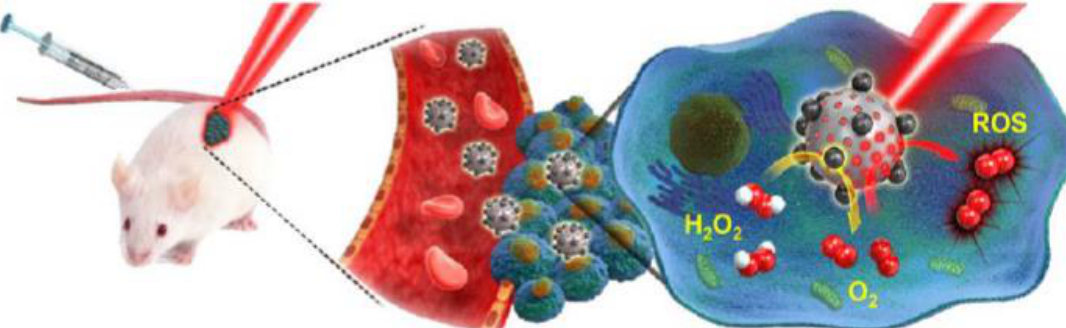
Figure 8. Photodynamic effect in therapy; the light stimulation is able to generate highly reactive oxygen species, inducing cellular apoptosis through oxidative stress and depletion of reductive species such as glutathione. The use of such dyes must be carefully addressed if they show long residence times, as their remainder activity may induce acute light sensitivity and chronic toxicity. Adapted from reference [155].